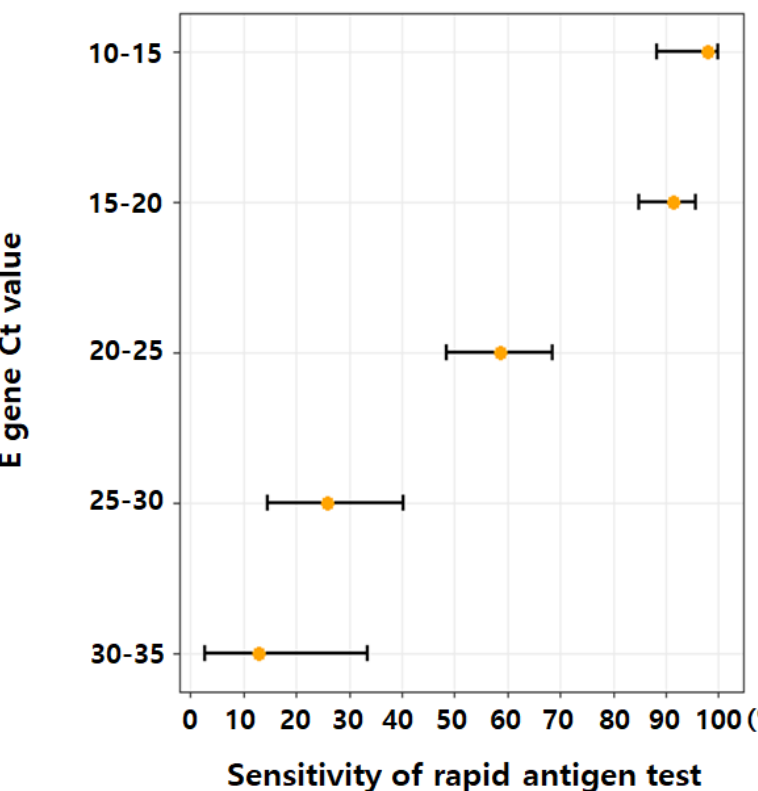
Figure 2. Sensitivity of RAT according to the E gene Ct value interval defining COVID-19 positive